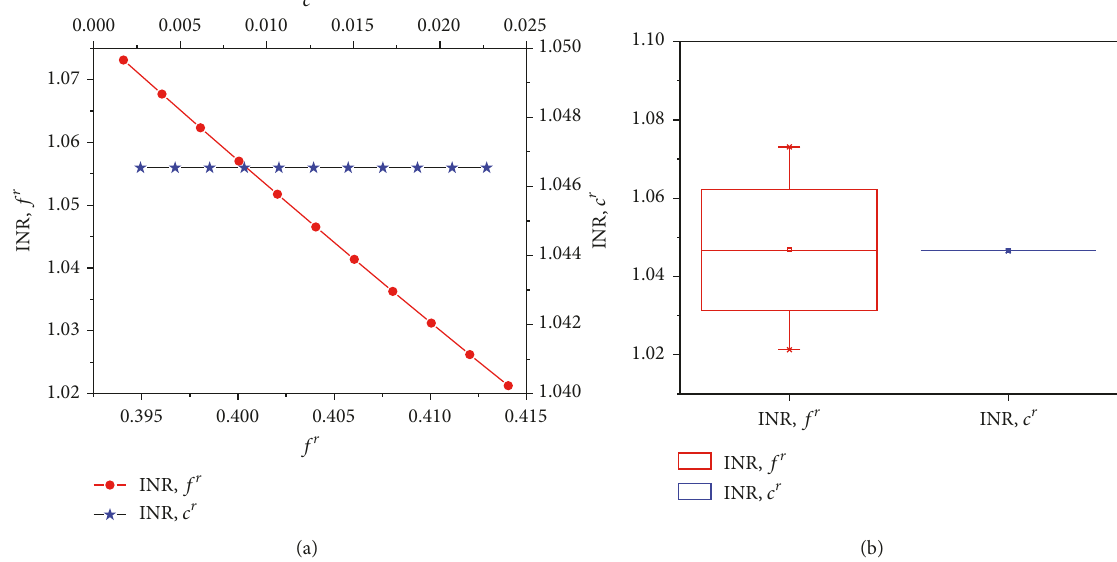
Figure 6: (a) Sensitivity analysis deviation of 𝑐 2 ( 𝑐 𝑟 2 ) and 𝑓 2 ( 𝑓 𝑟 2 ) and (b) box charts for INRs under changes of 𝑐 2 ( 𝑐 𝑟 2 ) and 𝑓 2 ( 𝑓 𝑟 2 ).